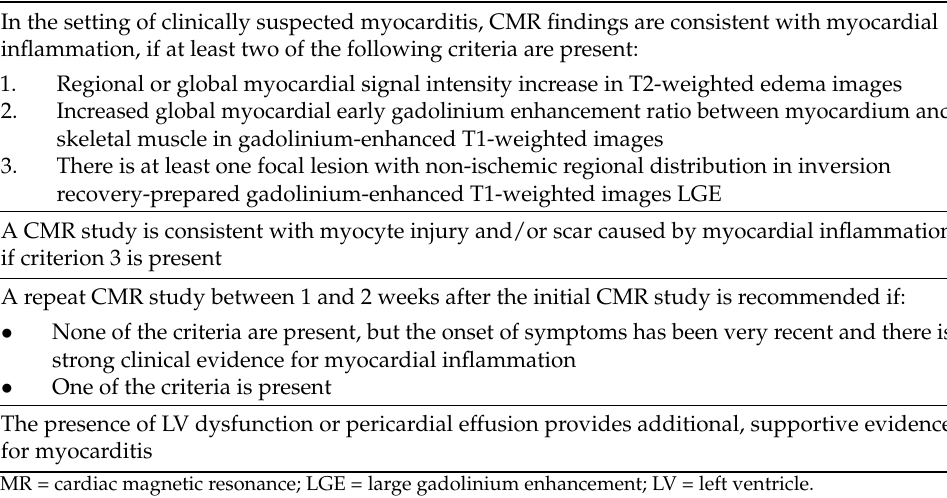
Table 5. Diagnostic cardiac magnetic resonance (CMR) criteria for